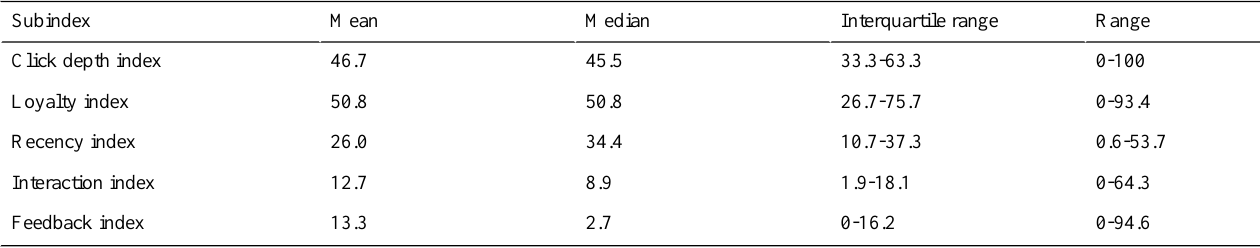
Table 3. Descriptive statistics of each subindex (N %).